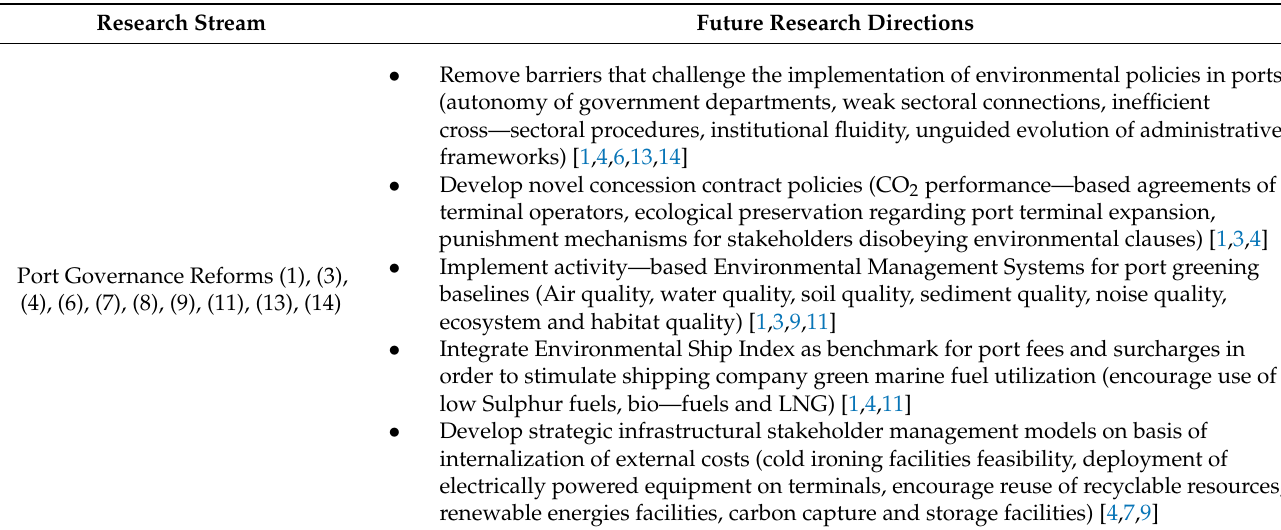
Table 6. Future research directions identified from the selected trending 15 scientific articles. Research